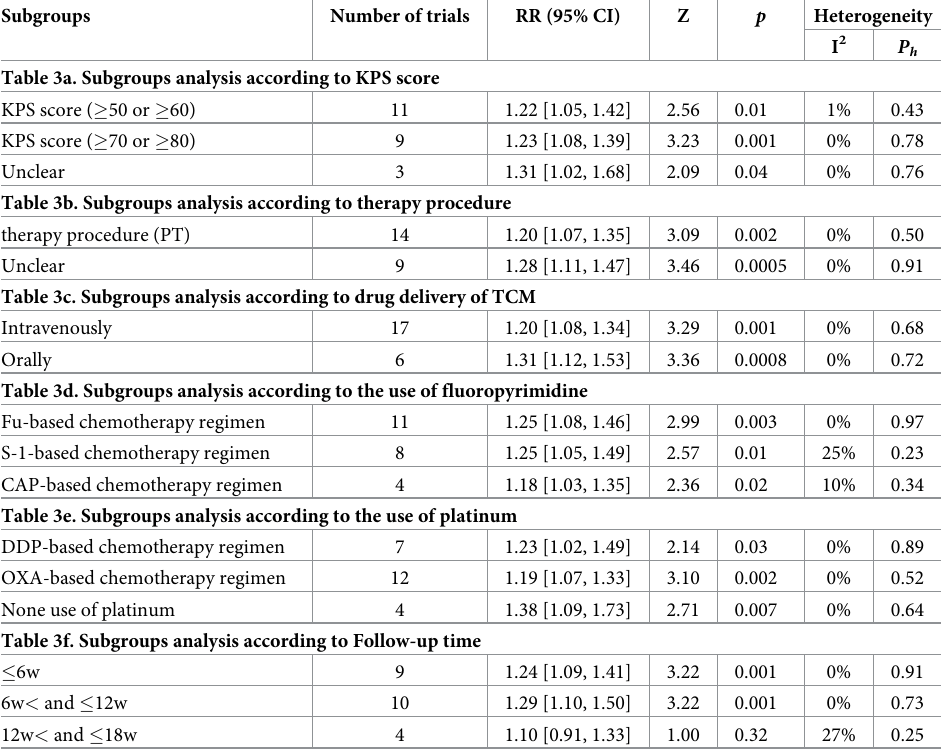
Table 3. Subgroup analysis of the ORR. Subgroups Number of trials Table 3a. Subgroups analysis according to KPS score